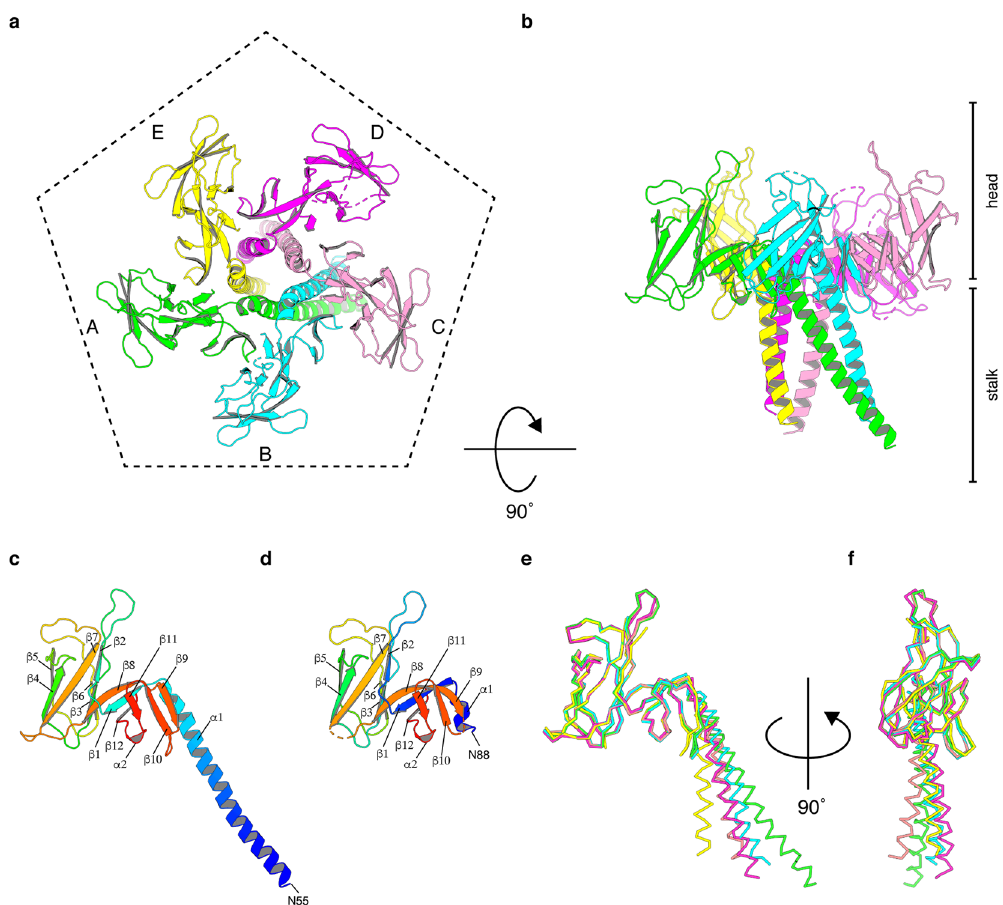
Fig. 2 Crystal structures of the hook cap from S. enterica . a , b A C α ribbon representation of the hook cap colored by subunits (A, green; B, cyan; C, pink; D, magenta; E, yellow), viewed from the top ( a ) and side ( b ) of the hook cap. c The subunit A of the hook cap in a and the chain A of FlgD 74-232 ( d ) depicted in rainbow color and labeled with secondary structures. e , f Superimposition of the fi ve subunits of the hook cap (chain A – E) in a for comparison viewing from two directions. Table 1 Structural re fi nement statistics of S. enterica